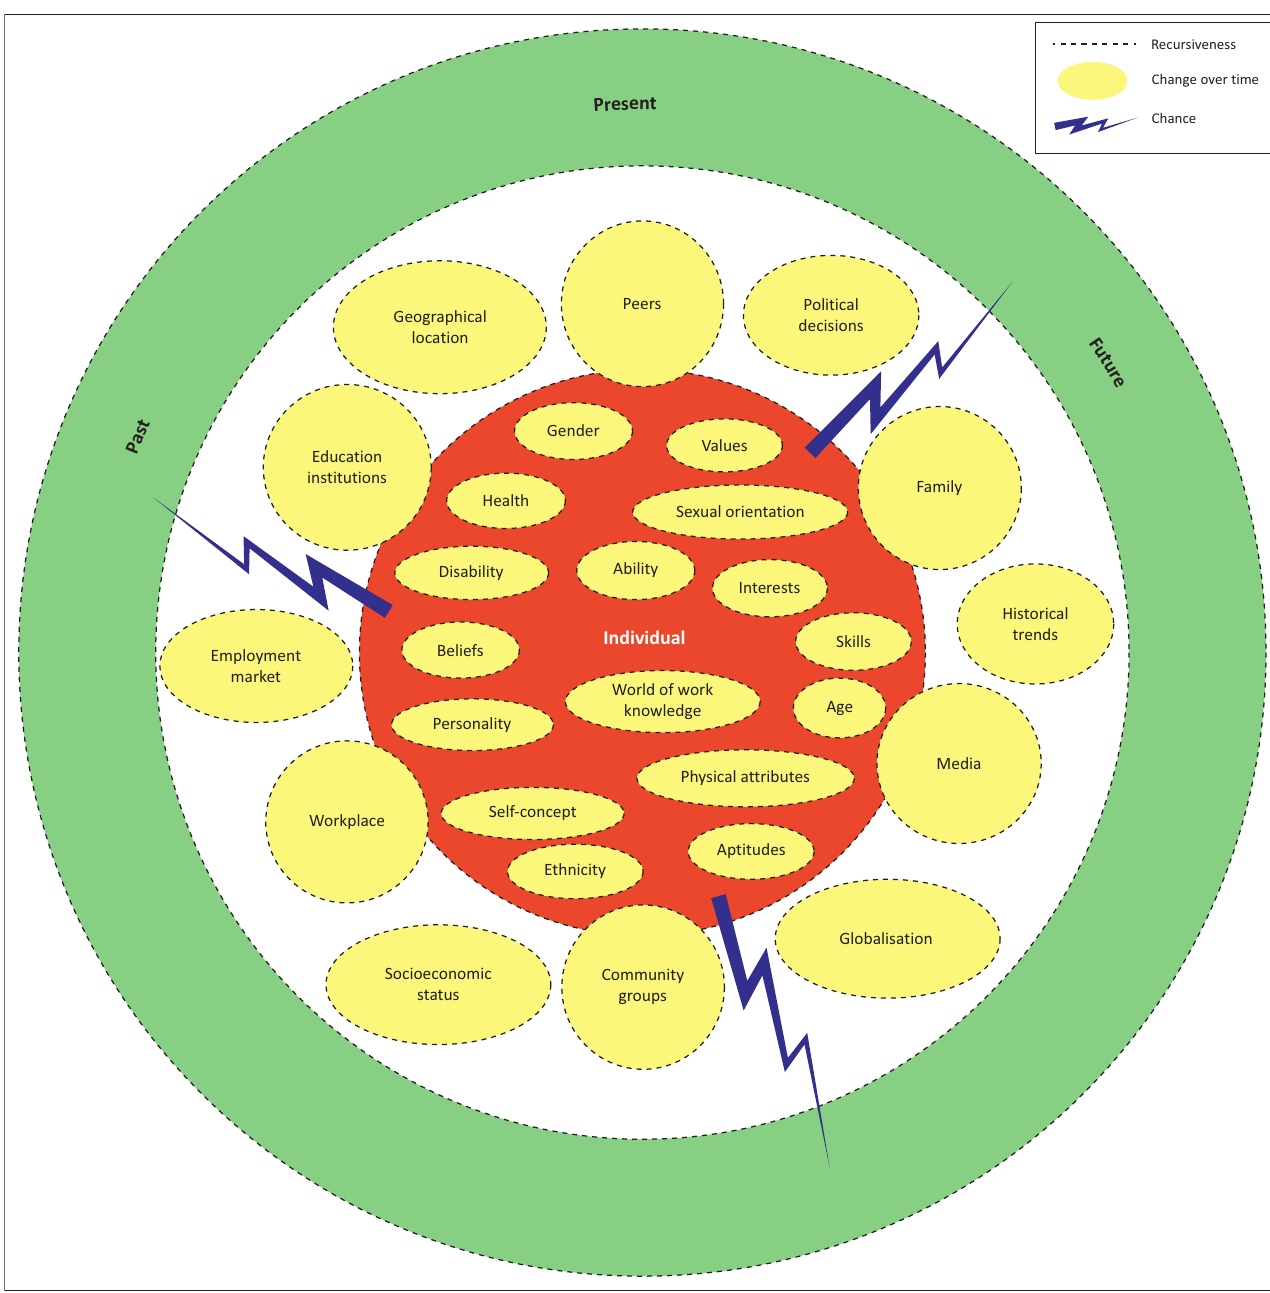
FIGURE 1: A systems-thinking framework that includes several interrelated systems to consider for individual career development.